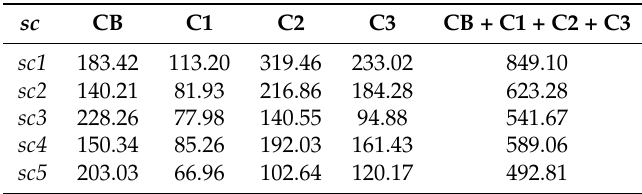
Table 7. Objective function